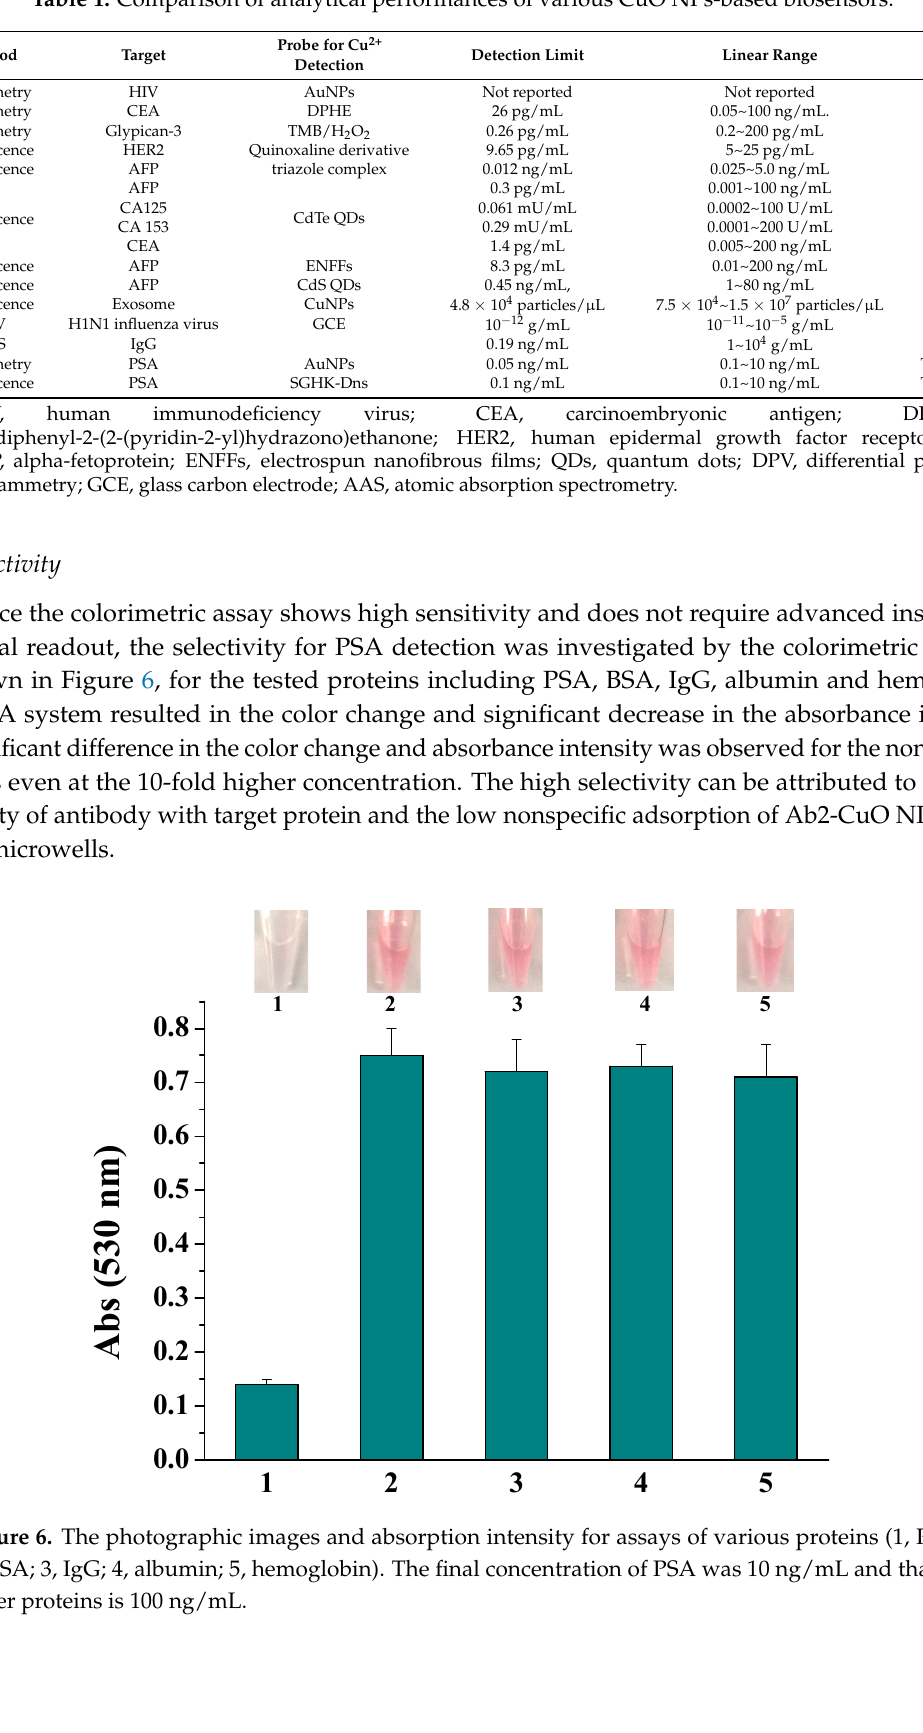
Table 1. Comparison of analytical performances of various CuO NPs-based biosensors.